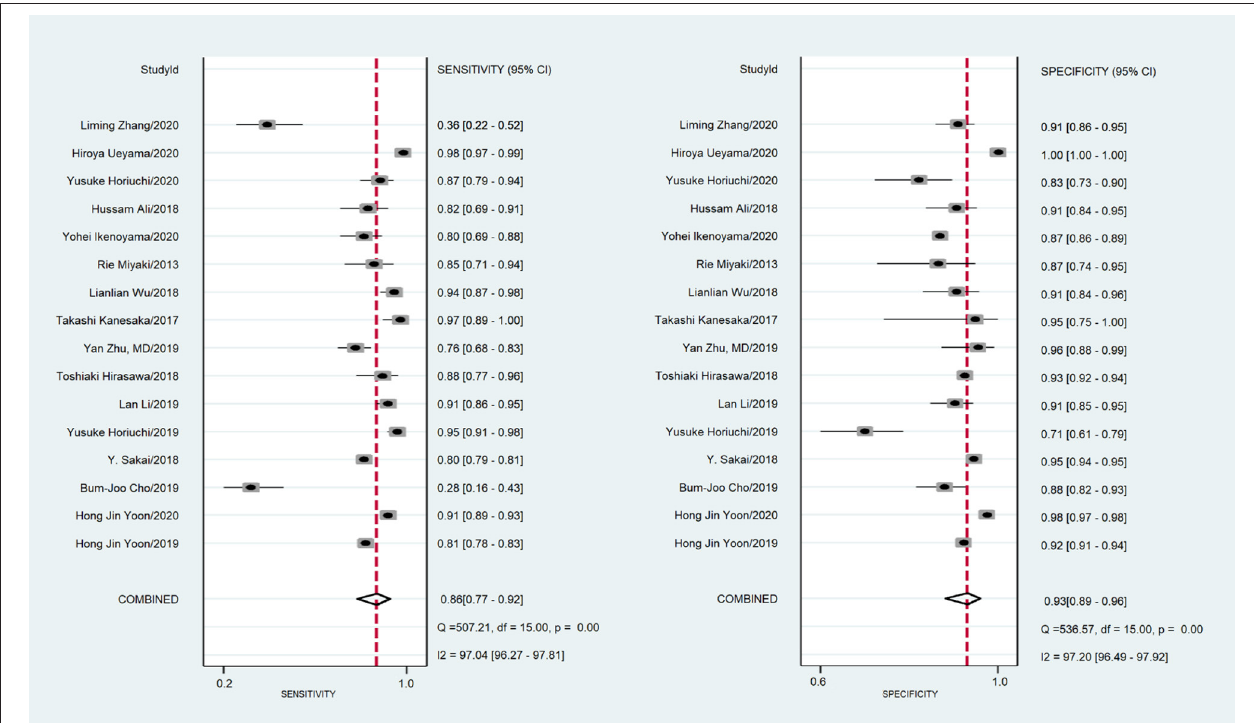
FIGURE 2 | The forest plot of pooled sensitivity and specificity of AI detection on EGC. The pooled sensitivity was 86% (95% CI, 77–92%) and specificity was 93% (95% CI, 89–96%).